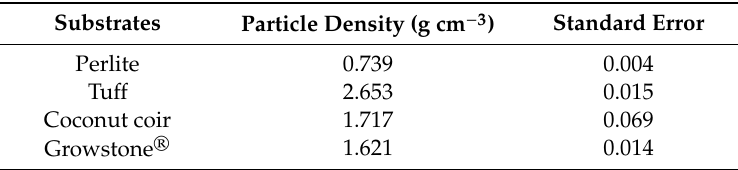
Table 2. Measured particle